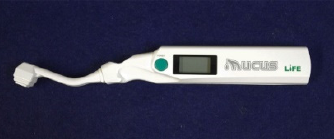
® ). Figure 1. An oral moisture-checking device (Mucus ® ).